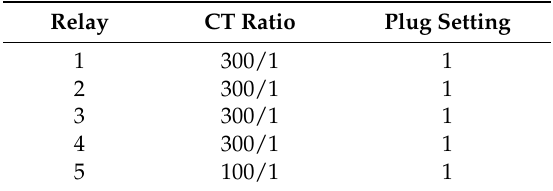
Table 6. CT ratios and plug settings of the relays for Case II.